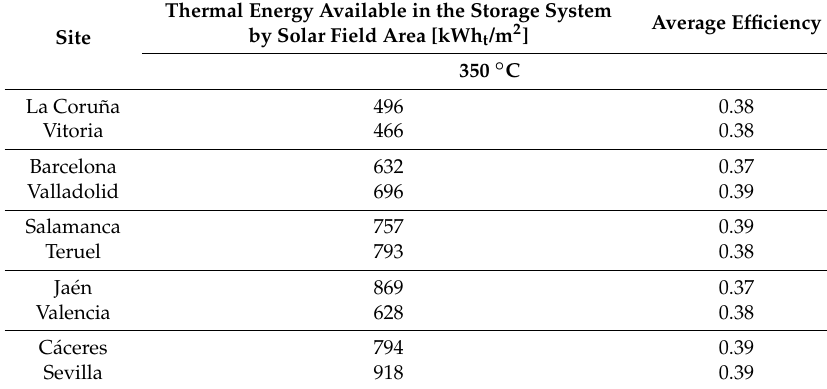
Table 20. Thermal energy available per solar field area and average efficiency for each site, PTC